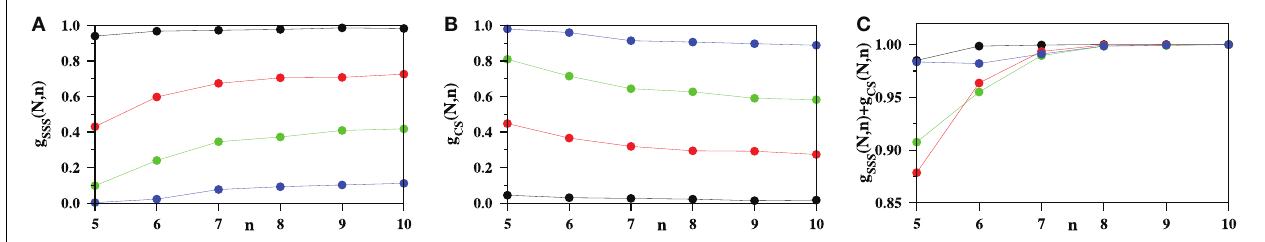
FIGURE 6 | The occurrence of two most prominent stationary states when the neighbor number n has been varied over a range from 5 to 10 and for different flock sizes N = 64 (black), 256 (red), 512 (green), and 1024 (blue). (A) The fraction g SSS ( N , n )